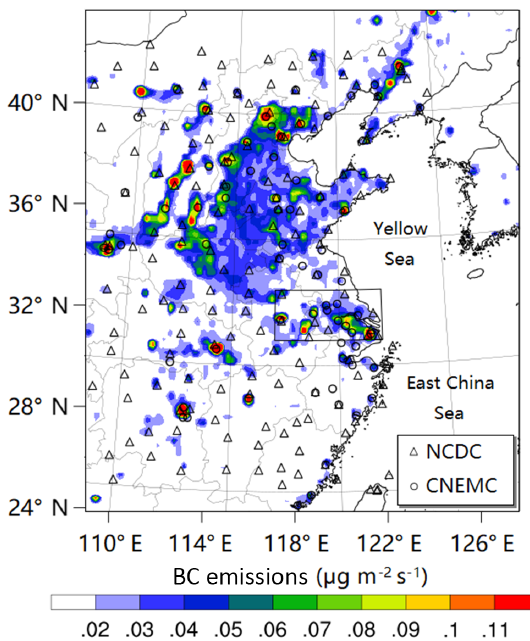
Figure 1. A map showing the WRF-Chem model domain, BC emis- sion and observation sites for meteorological parameters and air pollutants. Color-filled contours represent the BC emission from the EDGAR-HTAP dataset. The triangles represent the locations of 153 meteorological stations over eastern China from NCDC, and the cir- cles represent the locations of the 74 cities where the pollutant ob- servations are recorded. The rectangle denotes the YRD